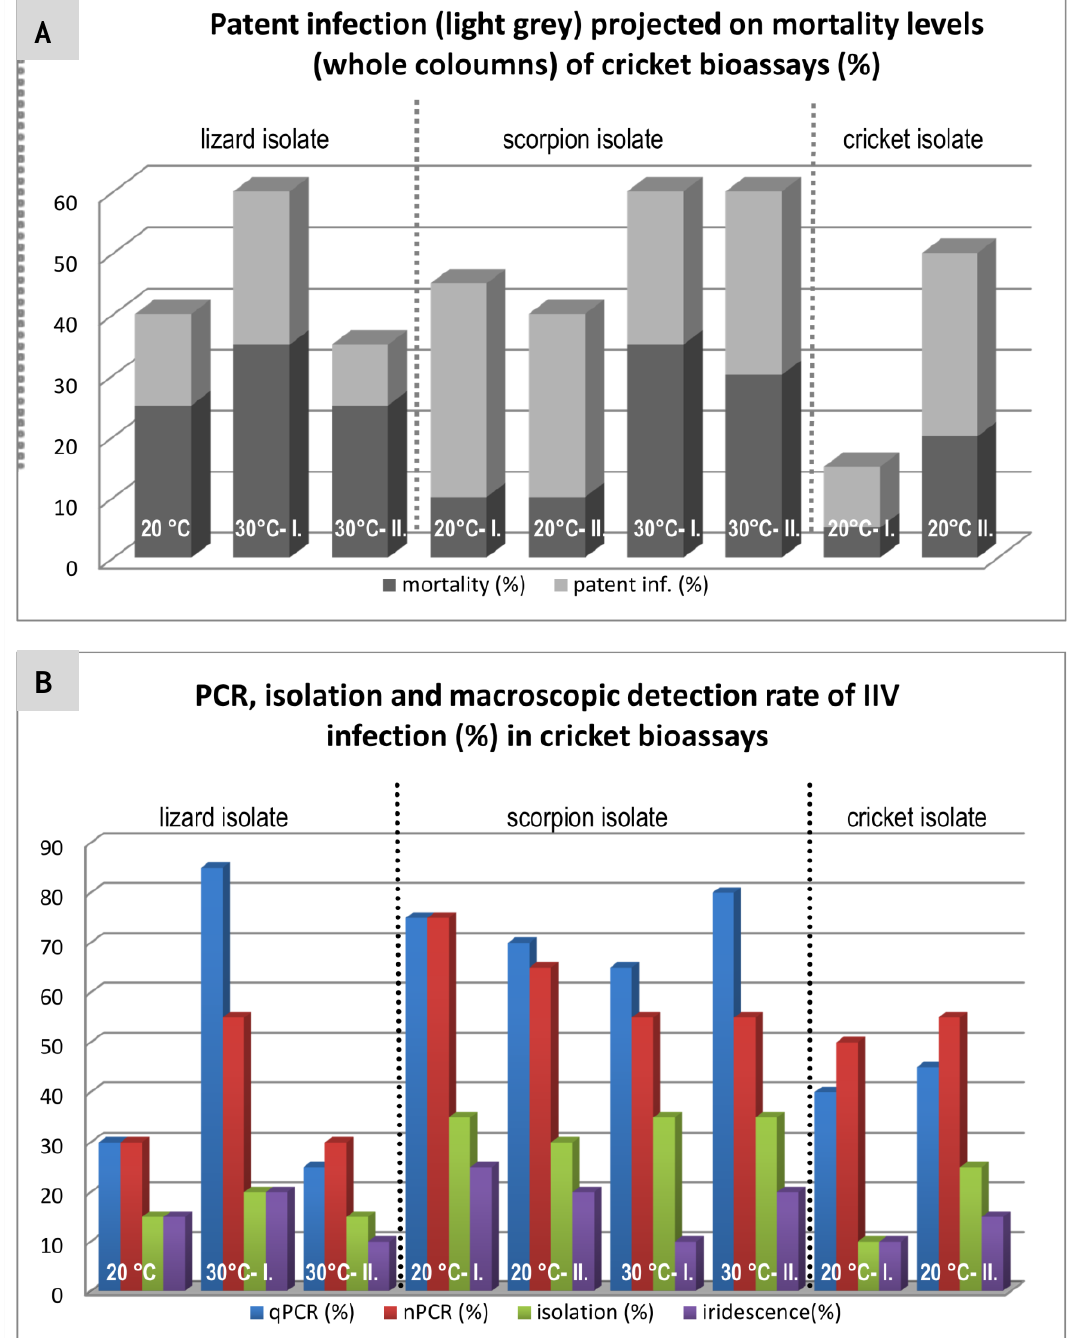
Figure 5. Graphic comparison of cricket bioassay results with di ff erent isolates at di ff erent temperatures. ( A ) Patent infection rates projected on mortality rates. ( B ) IIV infection rates detected by di ff erent